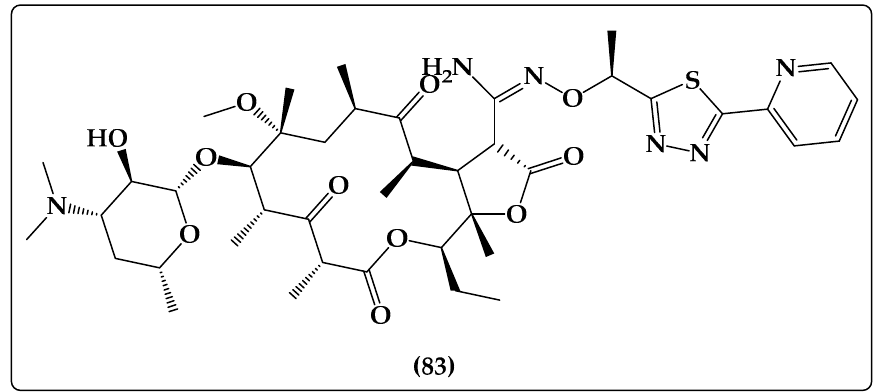
Figure 13. Chemical structure of Na fi thromycin ( 83 ).